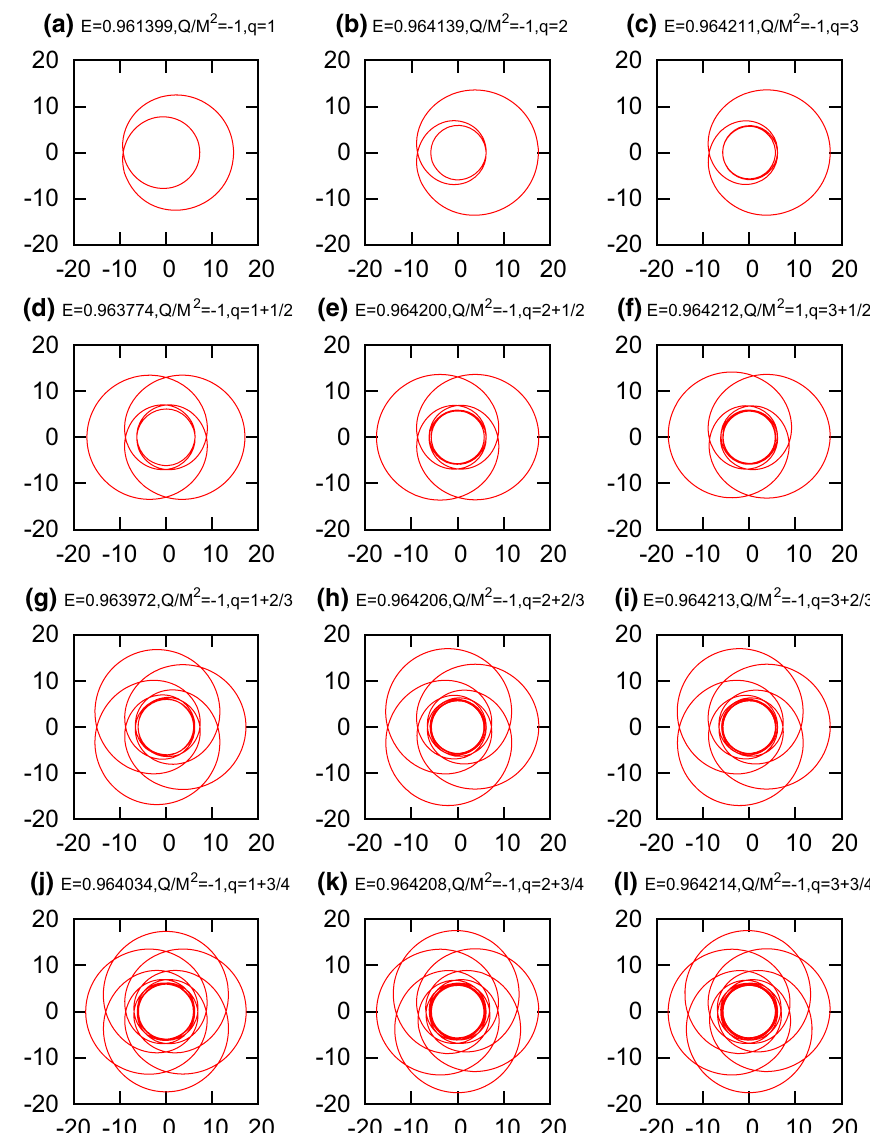
Fig. 11 Zoom-whirl periodic orbits ( z ,w,ν) around the DMPR brane-world black holes with Q = − M 2 and (cid:14) = 0 . 3